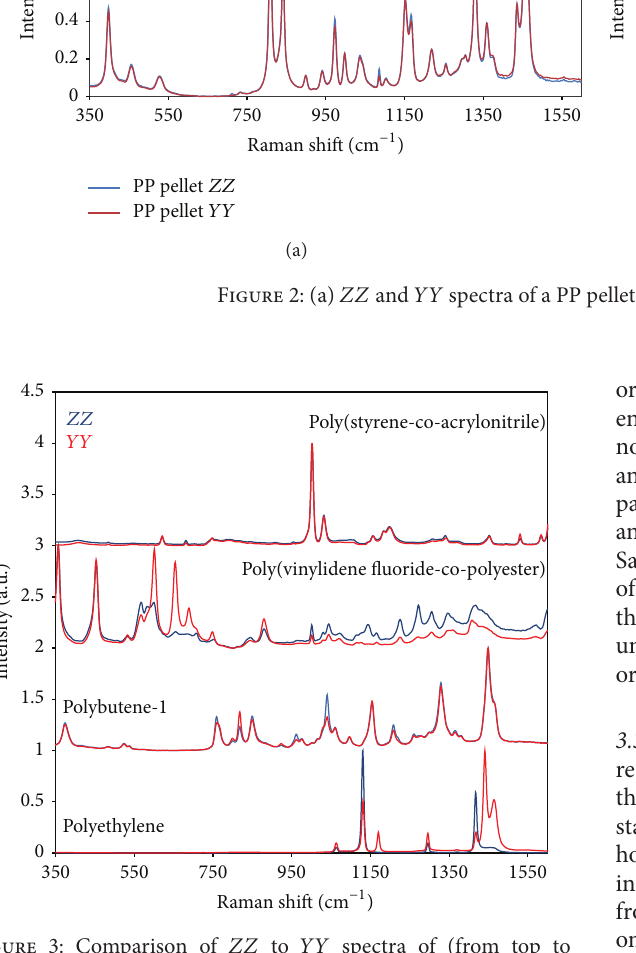
Figure 3: Comparison of 𝑍𝑍 to 𝑌𝑌 spectra of (from top to bottom) poly(styrene-co-acrylonitrile), poly(vinylidene fluoride- co-polyester), poly(1-butene), and